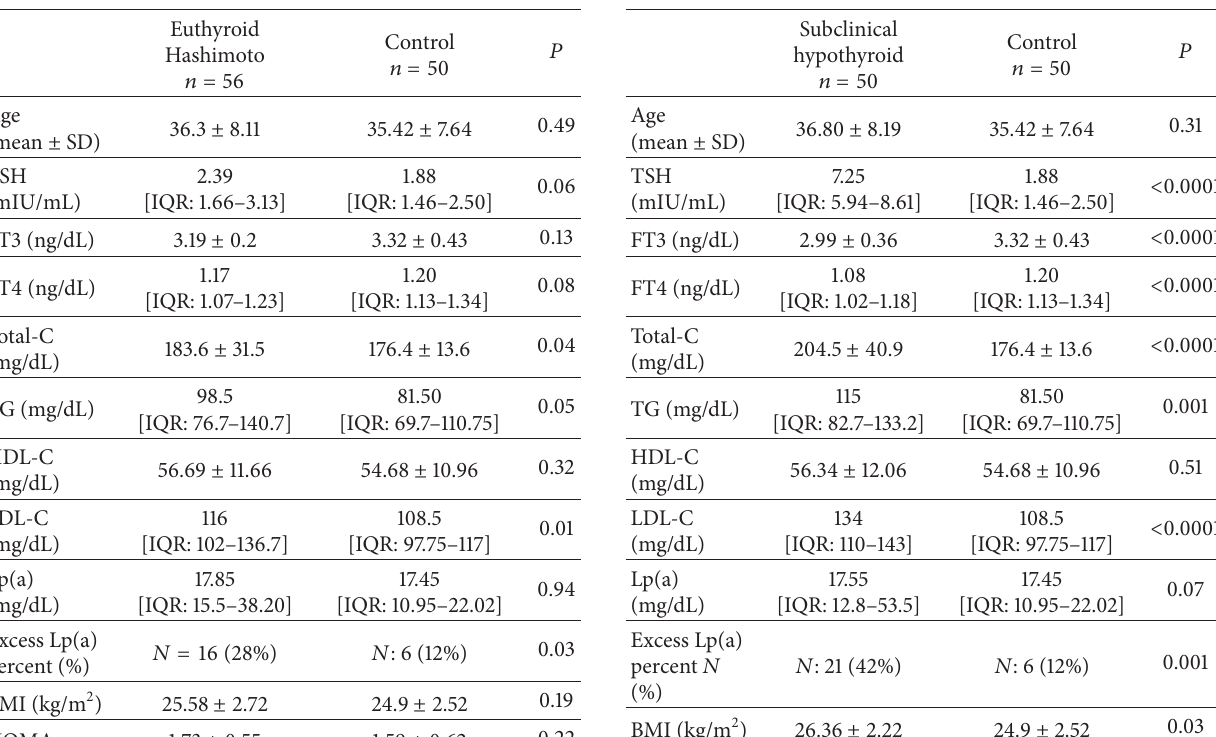
Table 2: Demographic and laboratory results of the euthyroid Hashimoto patients and the control group.